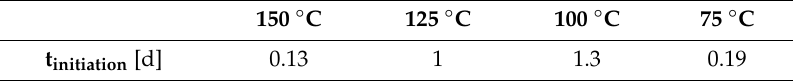
Table 1. Initiation time at the four ageing temperatures for EPDM.